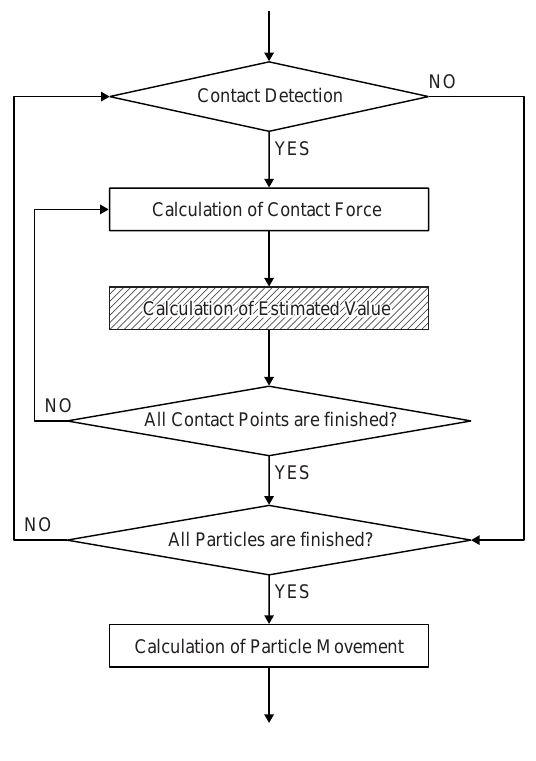
Algorithm of calculation of contact force and movement in the conventional method and the new